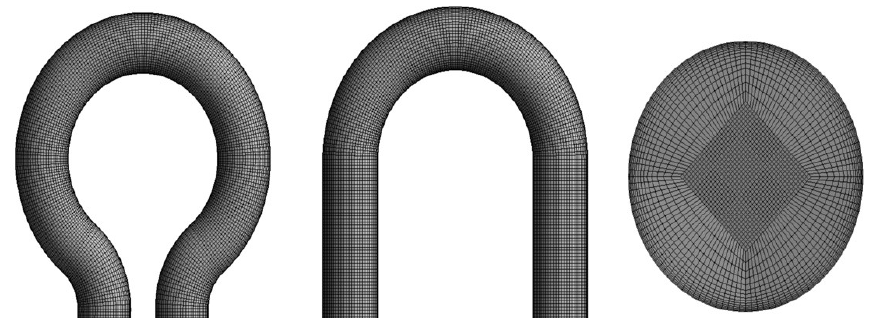
Figure 2. Computational